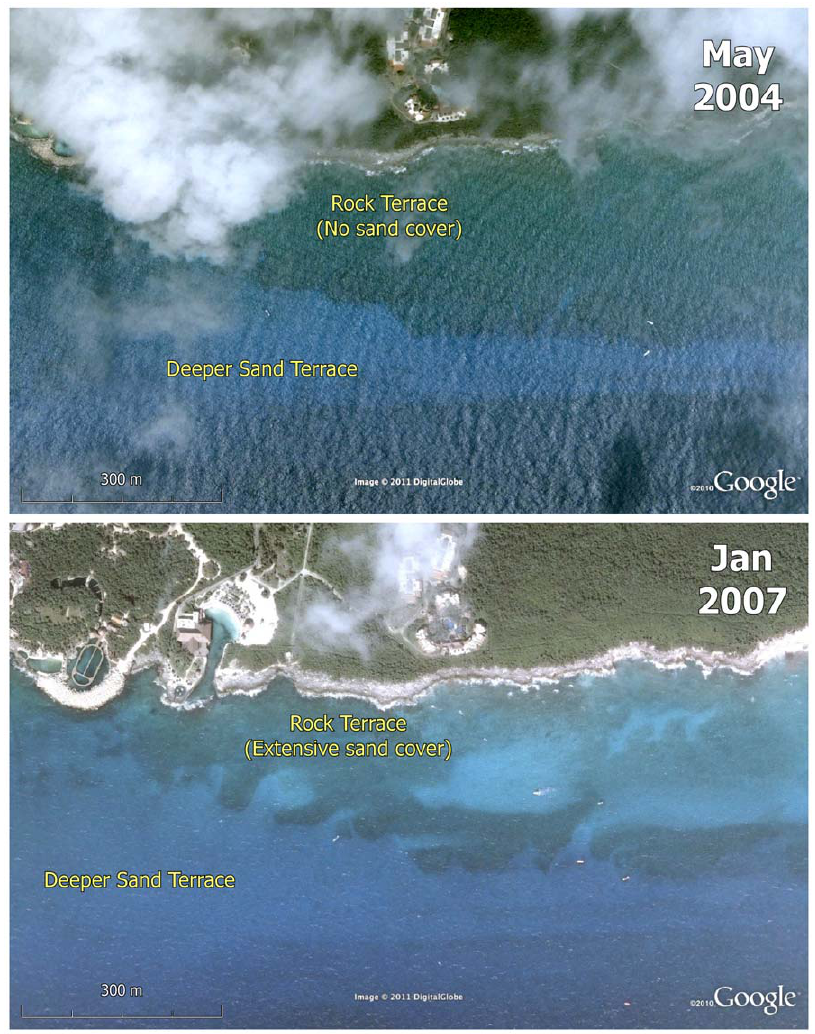
Figure 3. Satellite images of Xcaret showing sediment flux. Sequential satellite images showing the study site at Xcaret and a sediment-free rock terrace in May 2004, but with extensive sand cover during January 2007.